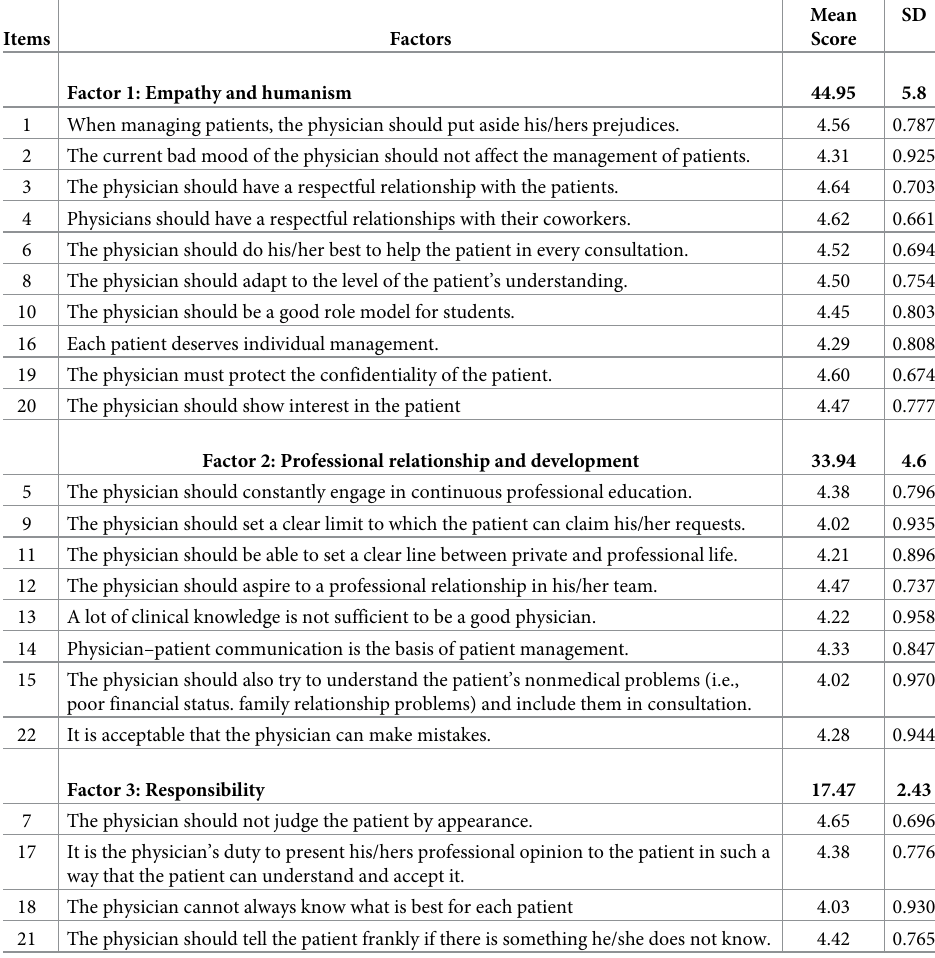
Table 6. Scores of PAS-TR.